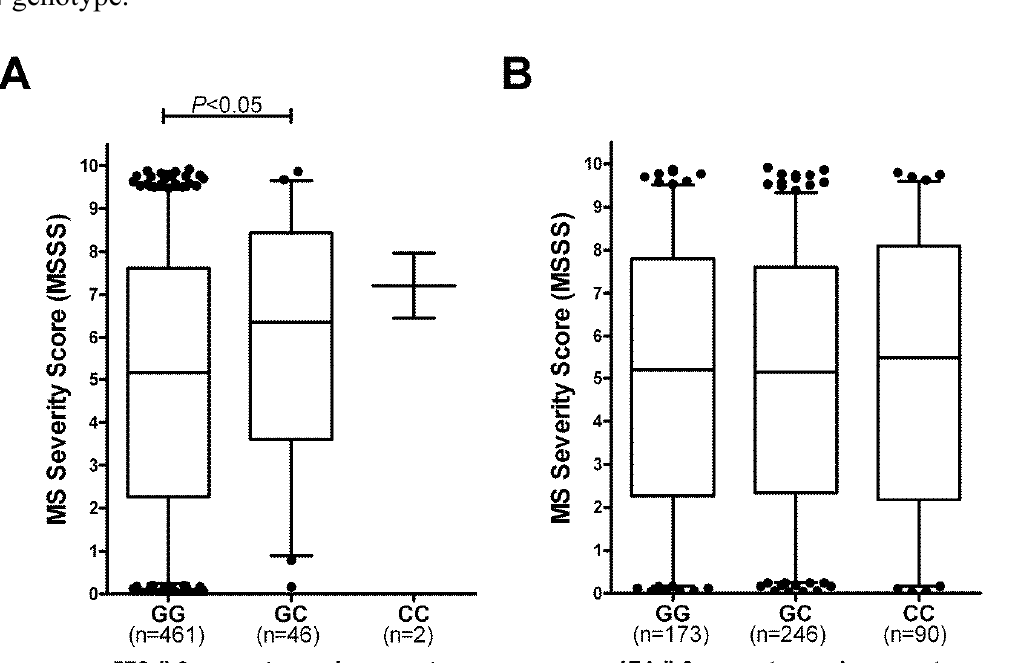
Figure 2. ( A ) Distribution of MS Severity Scores (MSSS) according to patient − 572 genotype. Each bar on the graphs represents the median and interquartile range. The whiskers represent the 5th and 95th percentiles, and outliers are shown as black circles above and below the plots; ( B ) Distribution of MSSS in patients subdivided on basis of − 174